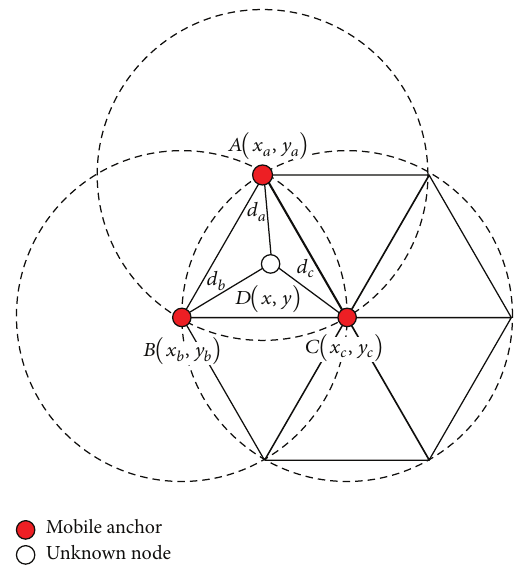
Figure 8: An example of the trilateration.